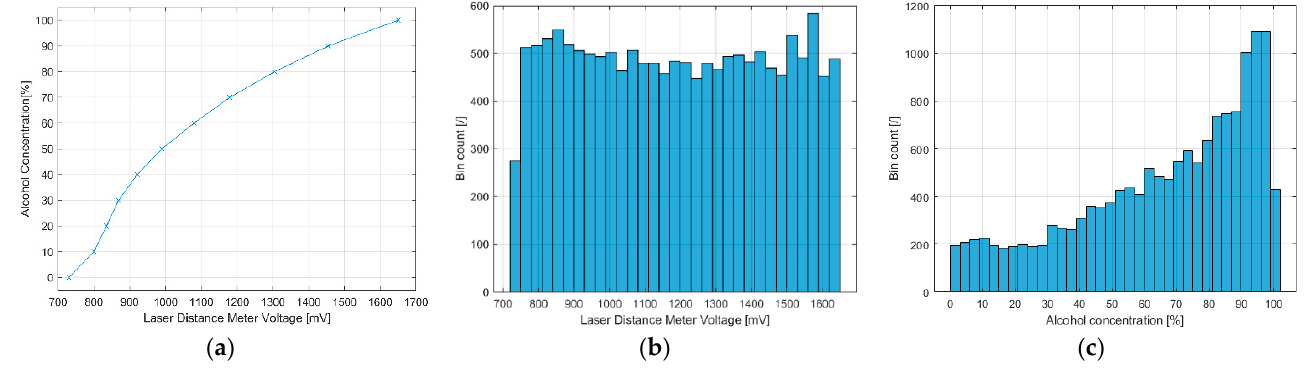
Figure 10. ( a ) Laser distance meter voltage to alcohol concentration mapping. X-marks represent 10% multiple voltage–concentration pairs and straight lines connecting them represent linearly in- terpolated values; dataset histograms in: ( b ) voltage domain and ( c ) alcohol concentration domain.